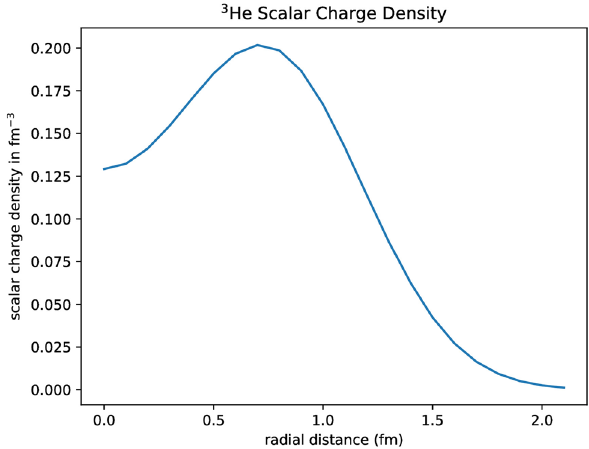
3 He, showing the ‘hole’ at the center.